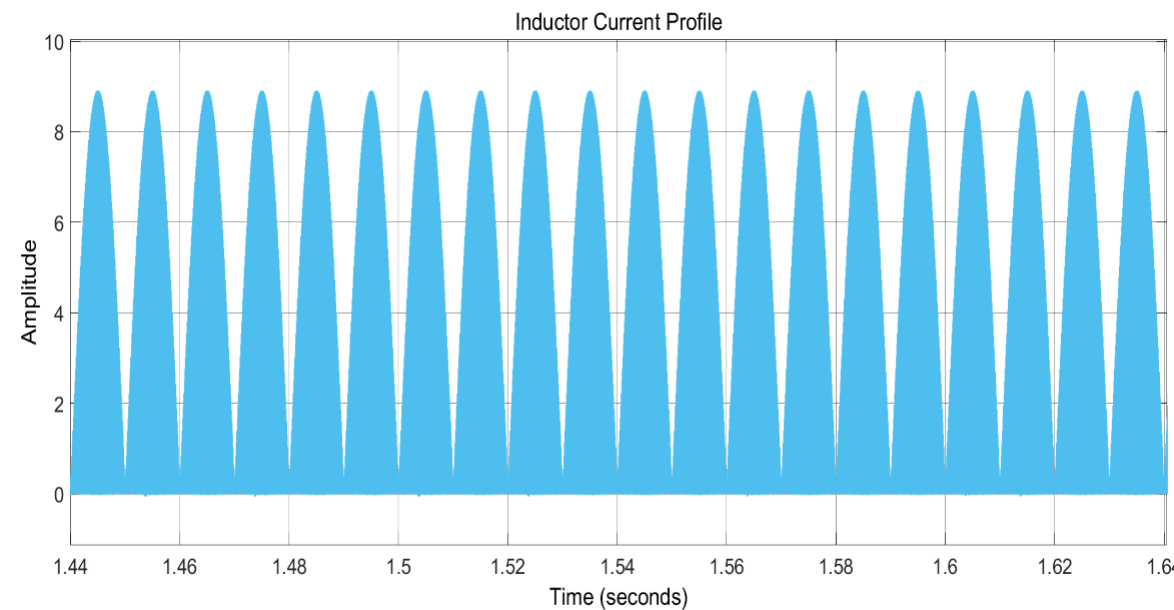
Figure 13. Inductor current waveform for L 1 = L 2 = L 3 = 0.5 mH.